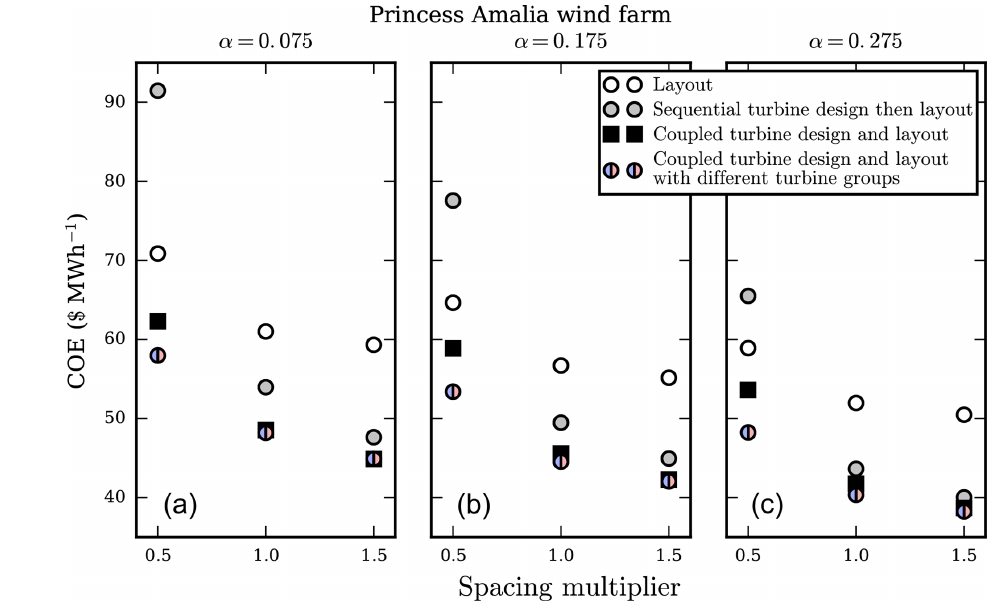
Figure 14. The optimal COE results for the Princess Amalia wind farm layout with 60 turbines. Each of the subfigures corresponds to optimization runs with a different shear exponent, from (a) to (c) α = 0 . 075, 0 . 175, and 0 . 275. Within each subfigure, the x axis shows the size of the wind farm based on the spacing multiplier, β = 0 . 5, 1 . 0, and 1 . 5. The different points represent the layout optimization, sequential optimization of turbine design and then layout, coupled layout-and-turbine-design optimization with homogeneous turbine design throughout the farm, and layout-and-turbine-design optimization with two different turbine design groups. Table 1. The percent COE decrease in the various optimization cases with respect to layout-only optimization. This table does not show the overall desirability of the optimal wind farm but the relative improvement of different considerations of turbine design optimization. In the table are shown results for each shear exponent, α , as well as each spacing multiplier, β , in which the smaller spacing multipliers represent farms with turbines that are more closely spaced. Bold entries performed worse than the baseline layout-only